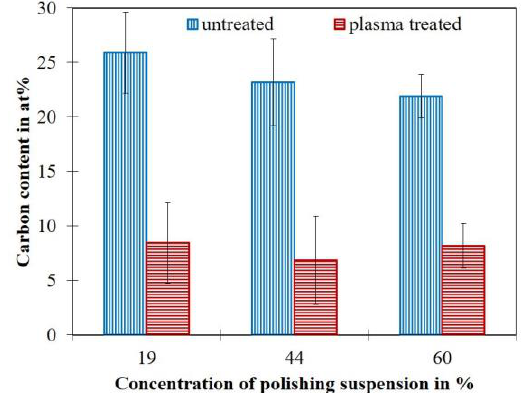
Fig. 1. Carbon content of zinc crown glass surfaces before and after plasma treatment; the samples were polished with different polishing suspension concentrations